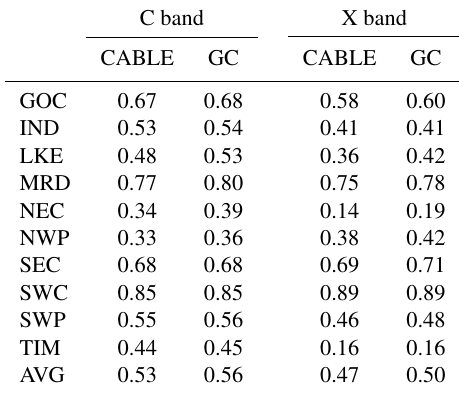
Table 3. NS coefficients between top soil moisture estimates and the satellite soil moisture observations from AMSR-E products over 10 different Australian basins. The area-weighted average value (AVG) is also